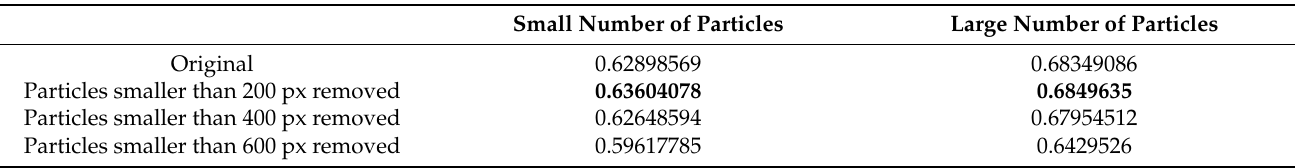
Table 15. F1-score for learning with incomplete labeling